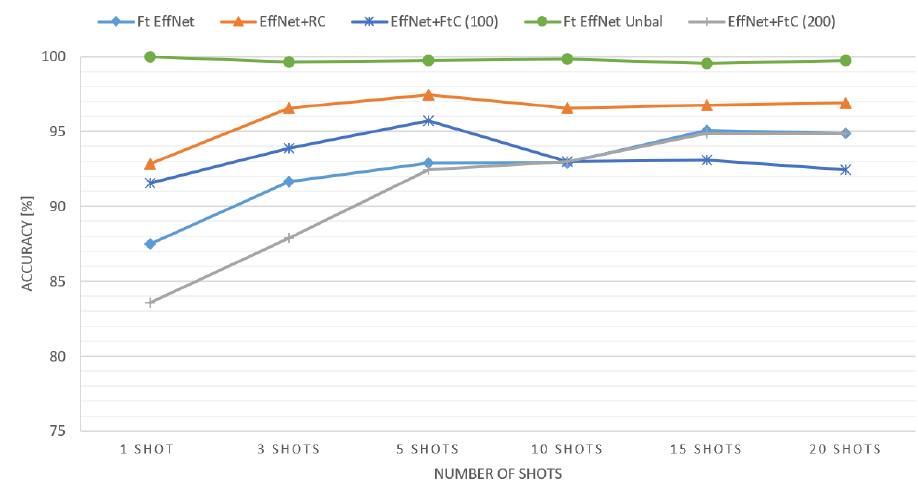
Figure 7. The accuracy of the different classification models for base classes. Ft EffNet: fine-tuned EfficienNet-B7; EffNet+RC: fixed EfficienNet-B7 backbone plus randomized classifier; EffNet+FtC: fixed EfficienNet-B7 backbone plus fine-tuned classifier; Ft EffNet Unbal: fine-tuned EfficienNet-B7 with unbalanced dataset.